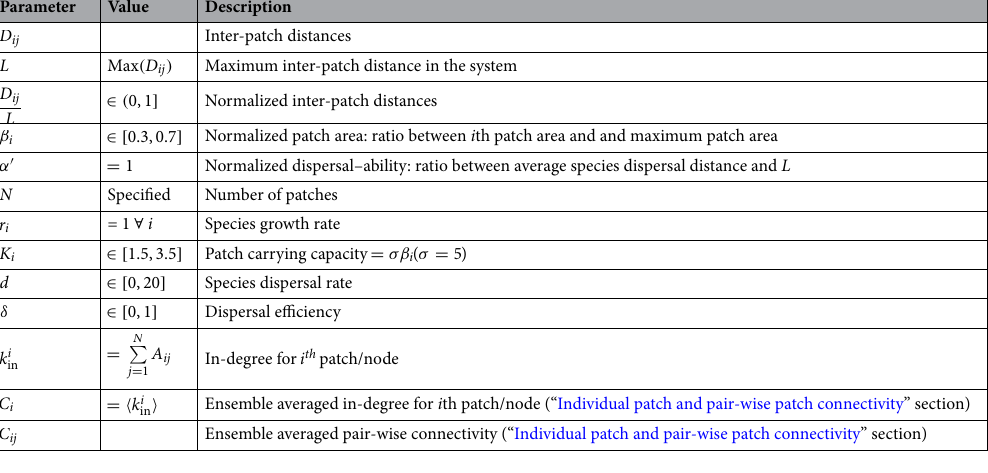
Table 1. Parameter summary.